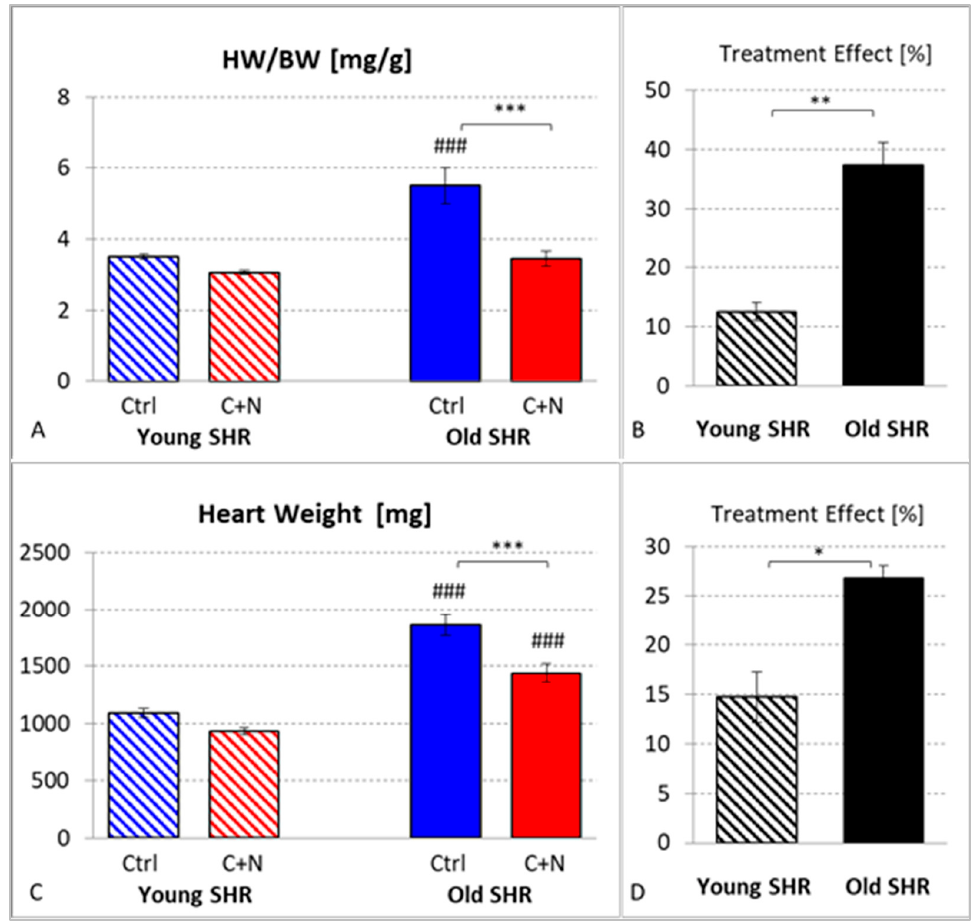
Figure 2. ( A ) Heart weight related to body weight in untreated (Ctrl) and treated (C+N) young and old SHRs. ( B ) Treatment effects on HW/BW in young and old SHRs (in % of corresponding average Ctrl value). ( C ) Absolute heart weight in untreated (Ctrl) and treated (C+N) young and old SHRs. ( D ): Treatment effects on heart weight in young and old SHRs (in % of corresponding average Ctrl value). Significance marks: ⎾ * ⏋ significant difference between marked groups, * p < 0.05, ** p < 0.01, *** p < 0.001; ### significant difference to corresponding young SHR group, p < 0.001.